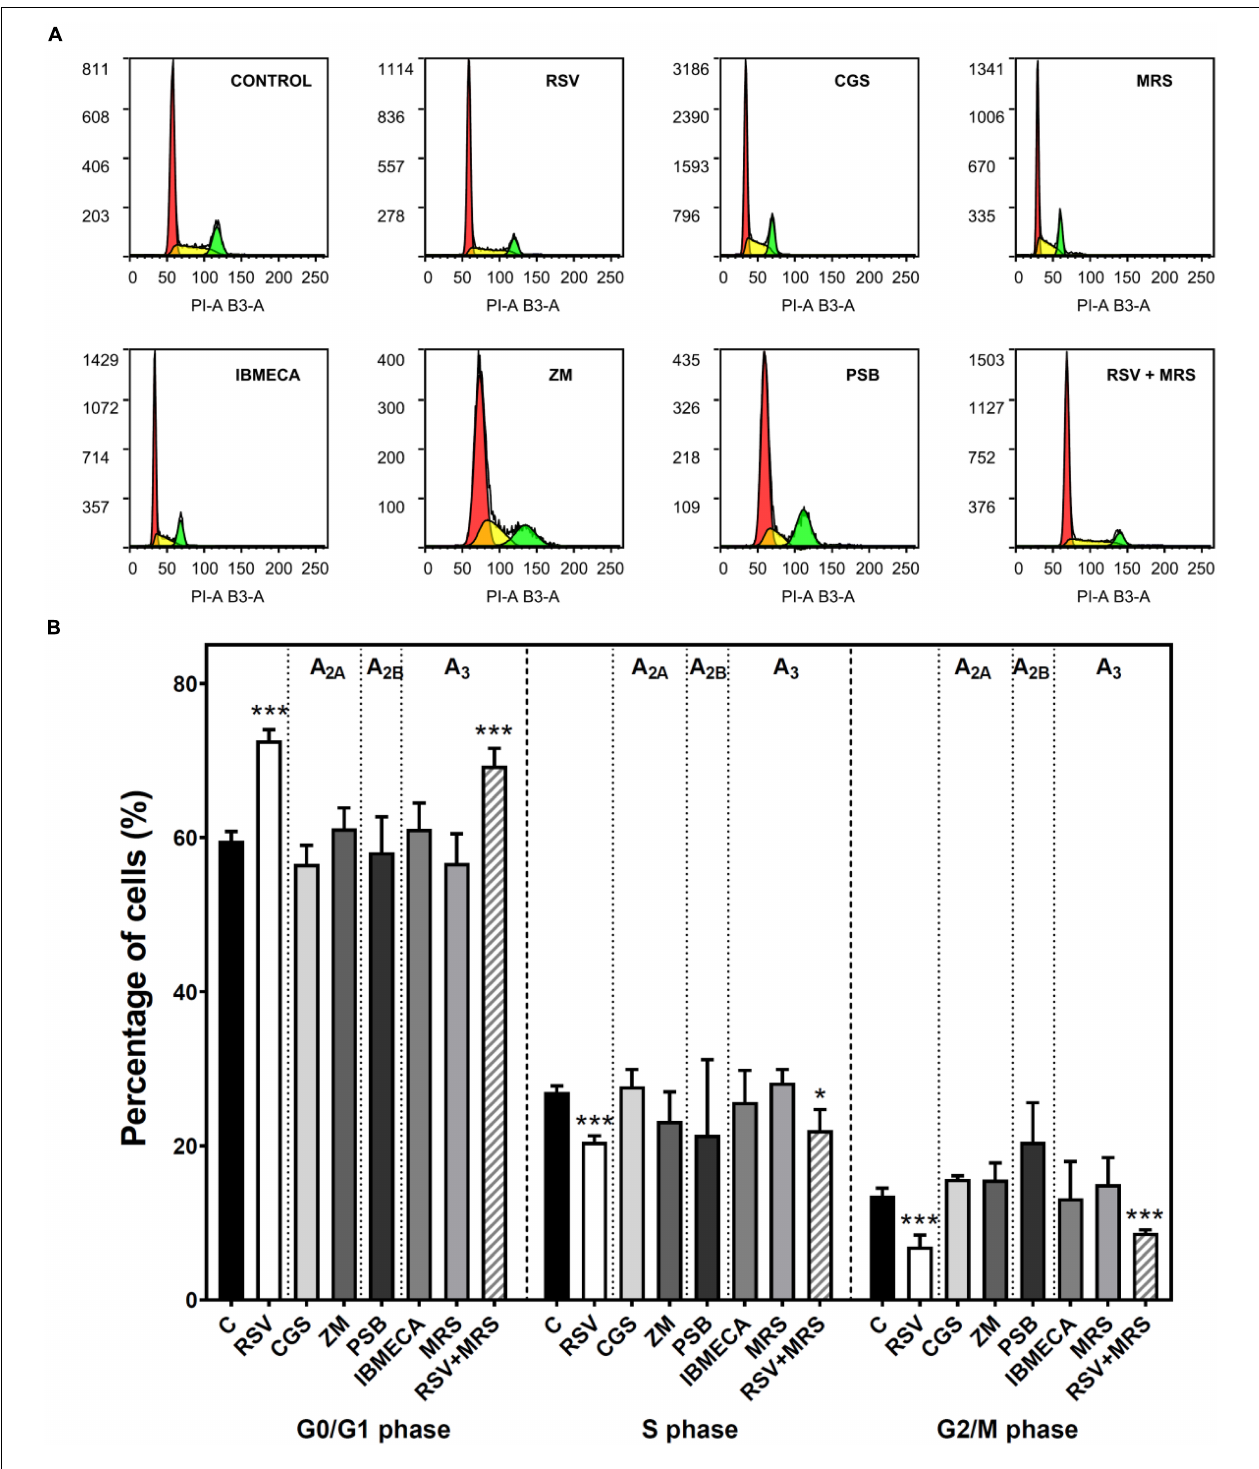
FIGURE 4 | Cell cycle analysis in C6 glioma cells. Cells were analyzed by flow cytometry after 24 h of treatment with 100 µ M RSV, 10 µ M CGS, 10 µ M MRS, 10 µ M IBMECA, 100 µ M ZM, or 100 µ M PSB. (A) Representative histogram of cell cycle analysis performed with propidium iodide staining of DNA showing the number of cells versus DNA content (PI-A B3-A). (B) Percentage of cells in each cell cycle phase. Data are means ± SEM of 3–15 independent experiments. * p < 0.05 and *** p < 0.001 significantly different from the control condition according to Student’s t -test. RSV, resveratrol; CGS, CGS21680; IBMECA, 2-Cl-IB-MECA; MRS, MRS1220; PSB, PSB1115; ZM,